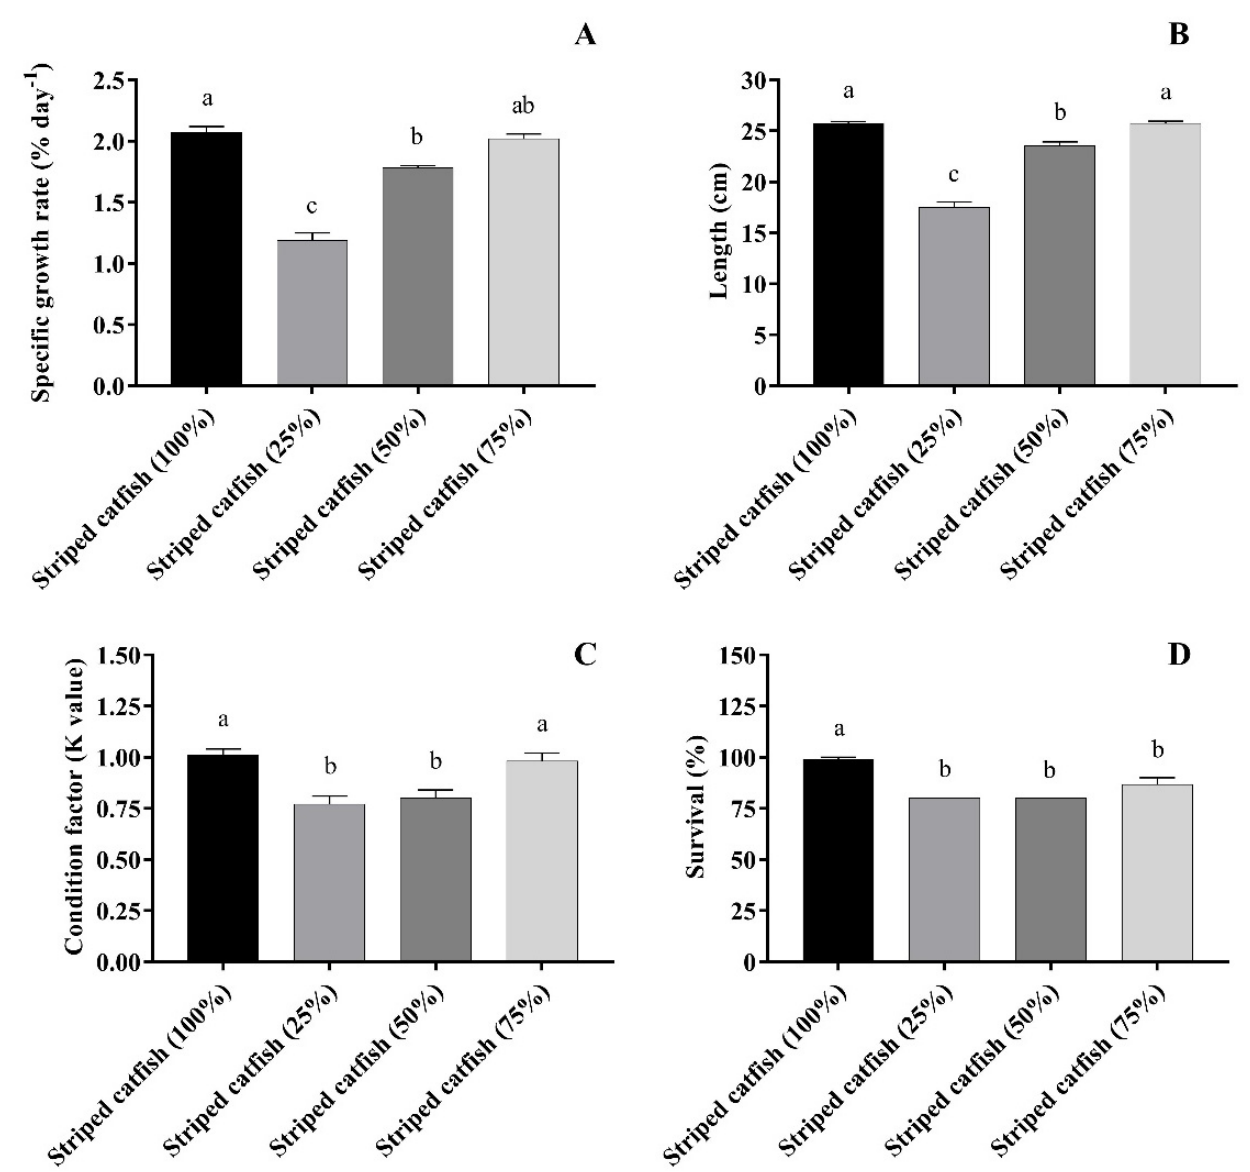
Figure 1. Growth performance ( A – C ) and survival % ( D ) of striped catfish, Pangasianodon hypophthalmus , maintained in monoculture and different polyculture proportions.